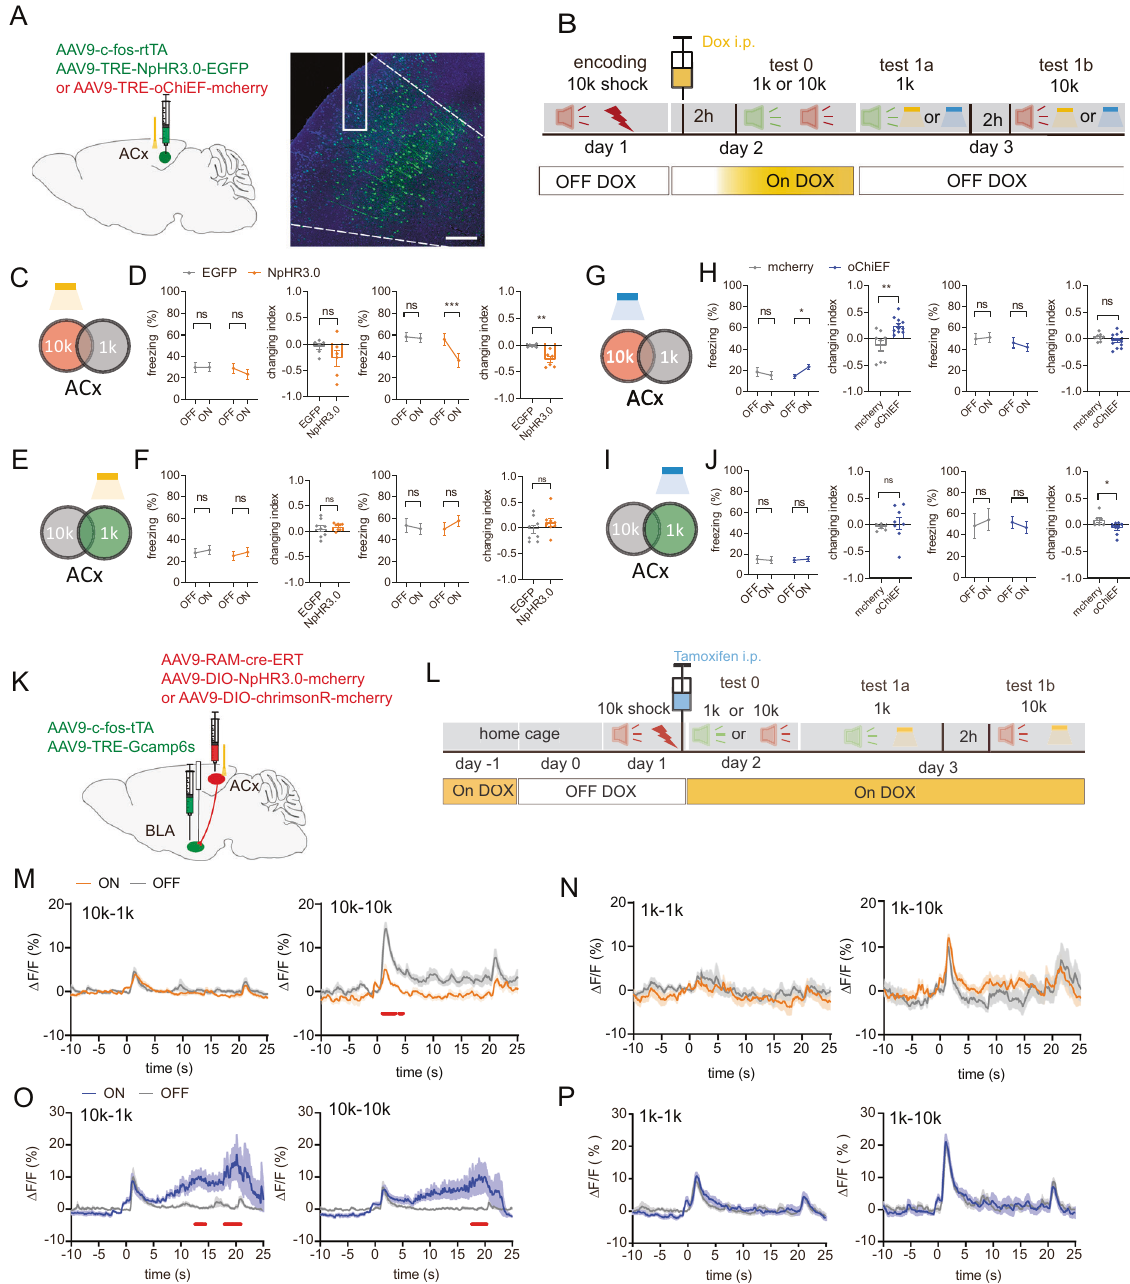
Fig. 3 Optogenetic manipulation of tone-responsive neurons in ACx modulates BLA engram cells to regulate DAFM. A Schematic of virus injection. AAV9-c-fos-rtTA and AAV9-TRE-NpHR3.0-EGFP or AAV9-TRE-oChiEF-mcherry were infused into the ACx and representative confocal images of NpHR3.0 expression in the ACx. Scale bar: 200 μ m. B Behavioral design. C , E , G , and I Schematic of optogenetic stimulation. D , F , H , J The percentage of the freezing time (1, 3) and the changing index (2, 4) in mice during 1 kHz retrieval stage (1, 2) or 10 kHz retrieval stage (3, 4) at day 3 when optogenetic inhibition ( D , F ) and activation ( H , J ) of the 10 kHz-tone responsive ACx neurons ( D , H ) and 1 kHz-tone responsive ACx neurons ( F , J ) ( D NpHR3.0, n = 6, EGFP, n = 6; F NpHR3.0, n = 8, EGFP, n = 8; H oChiEF, n = 11, mCherry, n = 8; J oChiEF, n = 8, mCherry, n = 6). ( K ), Schematic of virus injection. AAV9-c-fos-tTA and AAV9-TRE-Gcamp6s were infused into the BLA, and AAV9-RAM-cre-ERT, AAV9-DIO-NpHR3.0-mcherry or AAV9- DIO-ChrimsonR-mCherry were infused into the ACx. Optical fi ber was implanted in the ACx. Gcamp6s was injected to record neural activity of BLA engram cells by optical fi ber. L Behavioral design. M – P The mean and SEM of the corresponding Ca 2 + signal of engram cells in the BLA during 1 kHz retrieval stage ( M – P , left) or 10 kHz retrieval stage ( M – P right) at day 3 when inhibiting or activation of the 10 kHz-tone-responsive ACx neurons ( M , O ) or 1 kHz-tone-responsive ACx neurons ( N , P ). l n = 6; m, n = 7). The under red line indicated bins between the light-on and light-off trials, with two-tailed unpaired t-test signi fi cance ( P < 0.05). Statistical tests: D , F , H ,